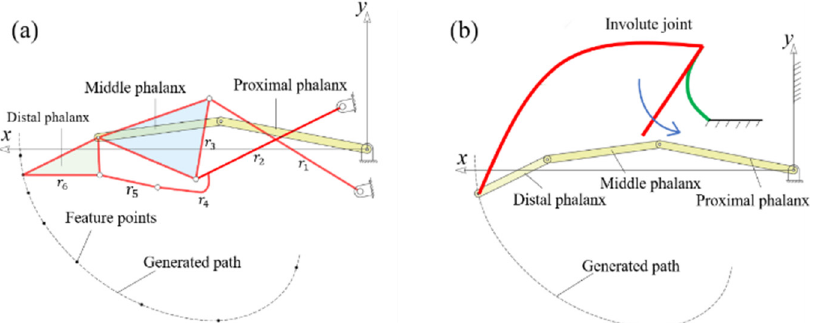
Figure 1. Comparison of the traditional linkage mechanism and the proposed joint model (Reprinted from [24]). ( a ) The n-bar linkage finger exoskeletons. ( b ) The proposed involute joint